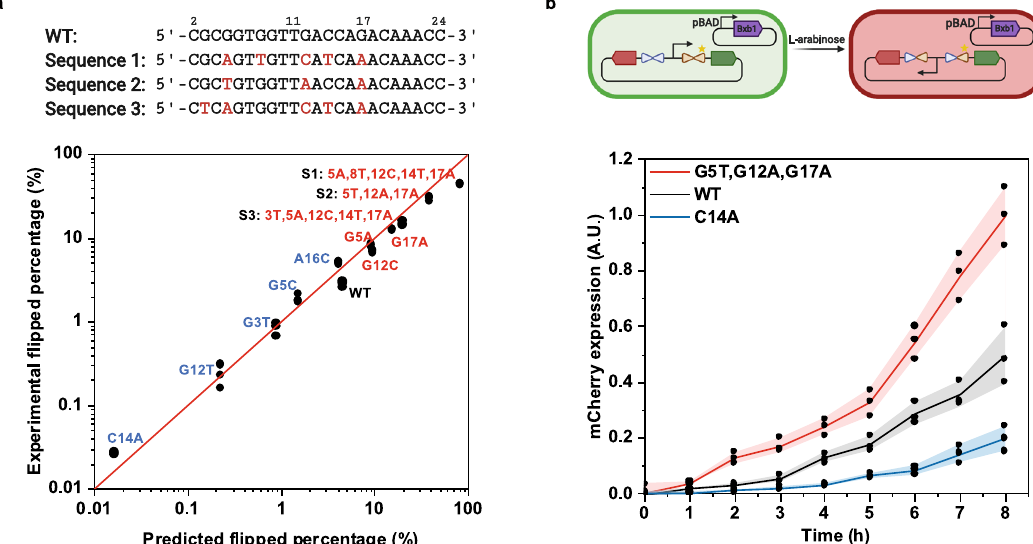
Fig. 5 Validation of individual sequences by measuring DNA fl ipped percentage in reaction buffer and mCherry expression in E. coli . a Accurate prediction of DNA fl ipped percentage of multiple individual sequences in the library with various predicted k fl ip values using the linear regression model (see Fig. 3 and Supplementary Method 2). The reactions, which contained 10 nM Bxb1 and 1 nM DNA substrate, were incubated at 30 °C for 5 min and then terminated by denaturation at 80 °C for 20 min. The fl ipped DNA fragment concentration was measured by qPCR. The black dots represent three technical replicates. Sequences 1, 2, and 3 at the top were predicted to be the most ef fi cient variants, each incorporating multiple mutations. b Three sequences with signi fi cantly different DNA fl ipping performances from a , tested in E. coli . Top: Donor plasmid with Bxb1 gene (purple block) and substrate plasmid are transformed into E. coli . DNA fl ipping of the promoter sequence between the GFP gene (green block) and mCherry gene (red block) gene